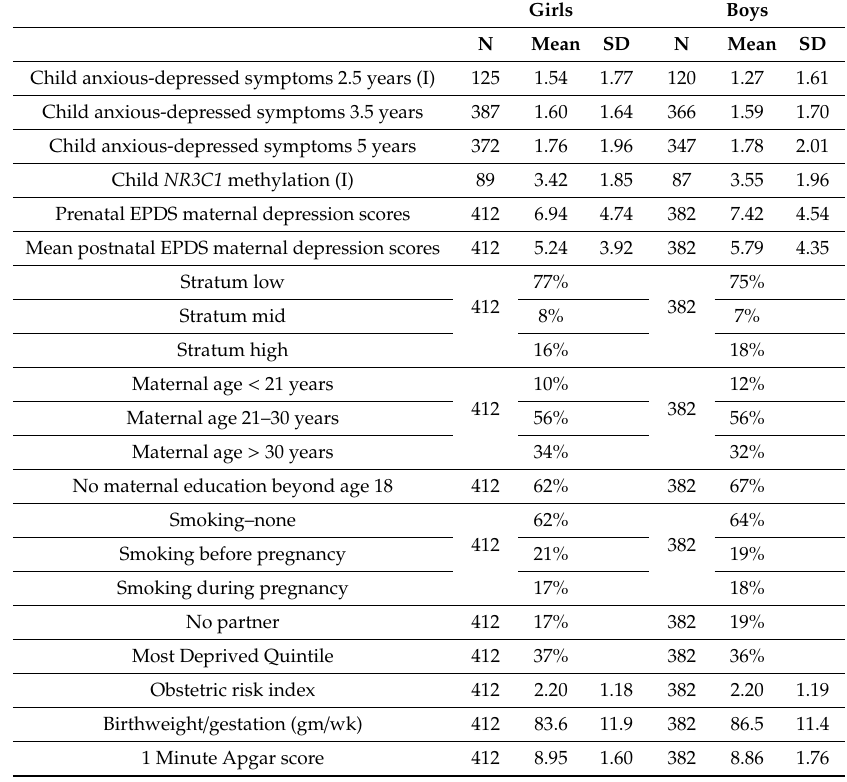
Table 1. Summary statistics for outcomes, predictors and variables included as potential confounders for the modelled sample (I = measure based on intensively assessed sub-sample